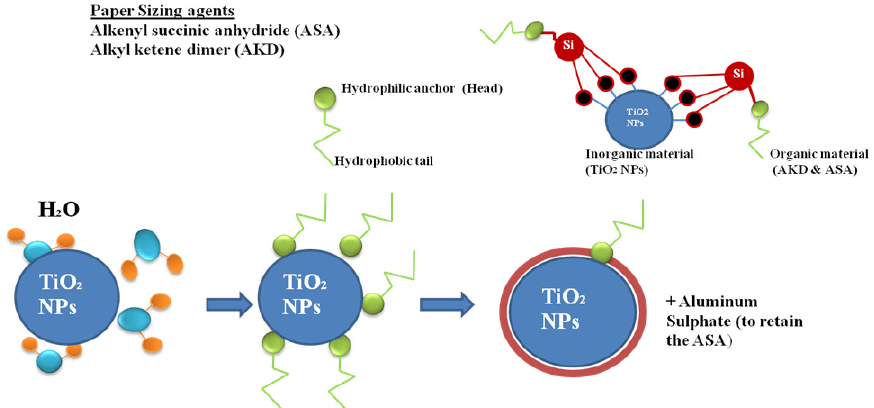
Figure 4. An illustration of surface modification concept of rutile-TiO 2 .